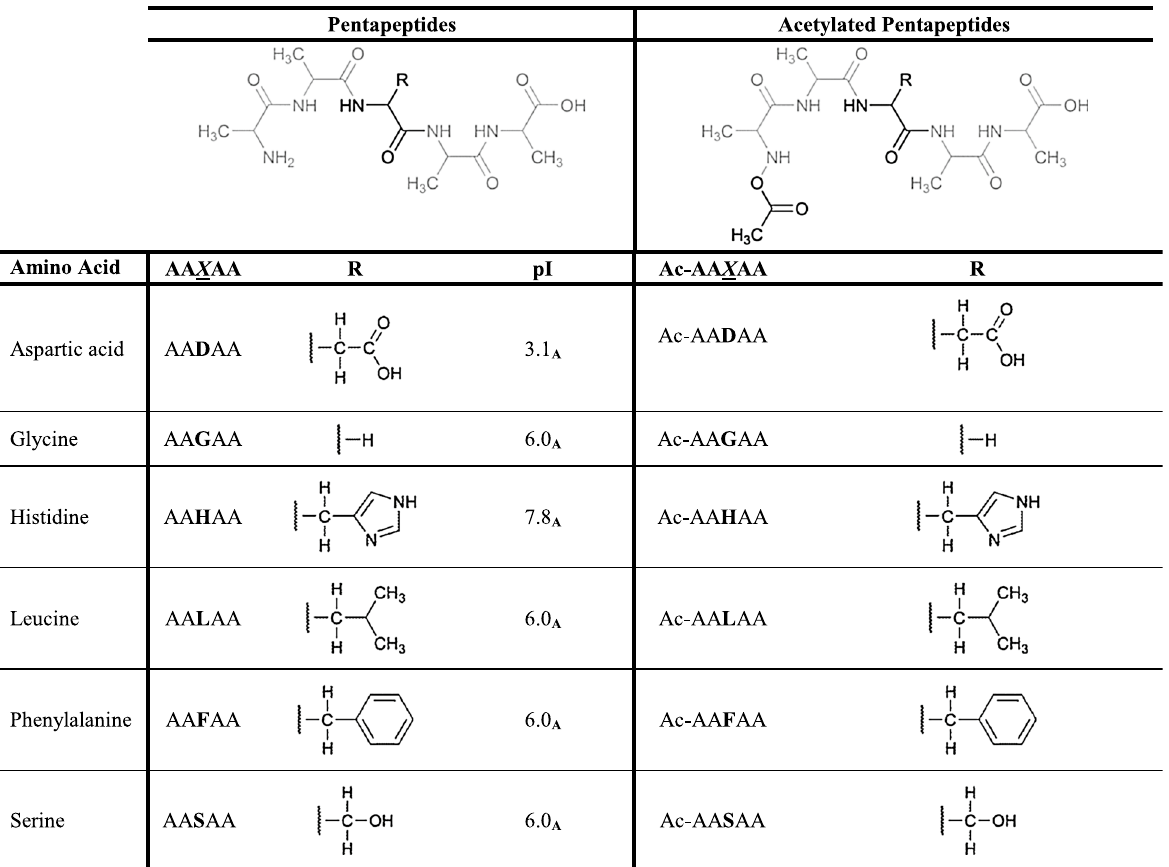
Table 3 Structures and pI values of the investigated pentapeptides and structures of the investigated acetylated penta-